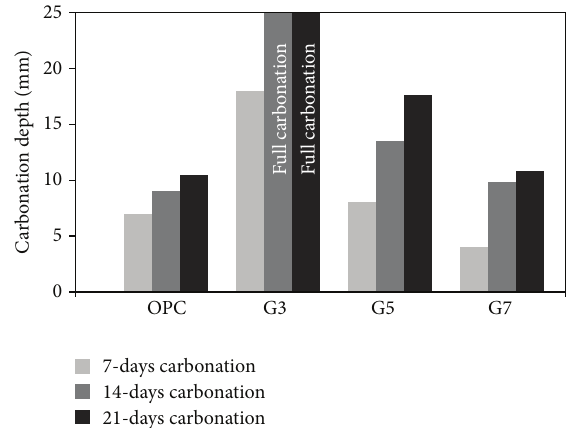
Figure 2: Carbonation depth of AAS mortar by accelerated carbon- ation.